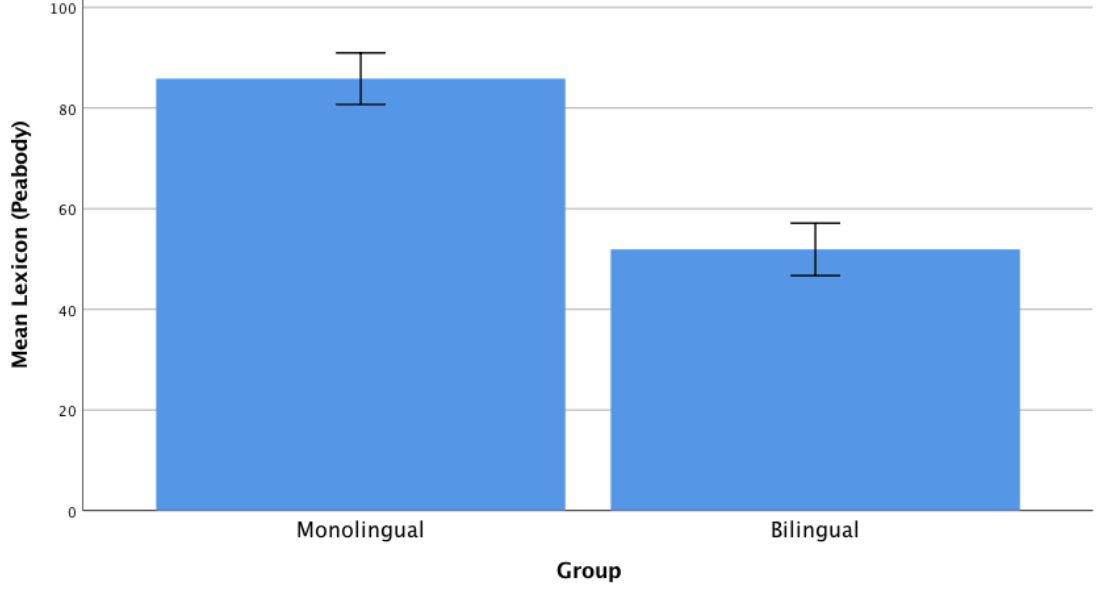
Figure 7. Mean TVIP Scores Compared between Monolingual and Bilingual Children